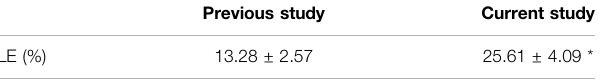
TABLE 1 | Comparison of CUR loading ef fi cacy of HES-CUR NPs between the current study and our previous study (Chen et al., 2020). Previous study Current study DLE